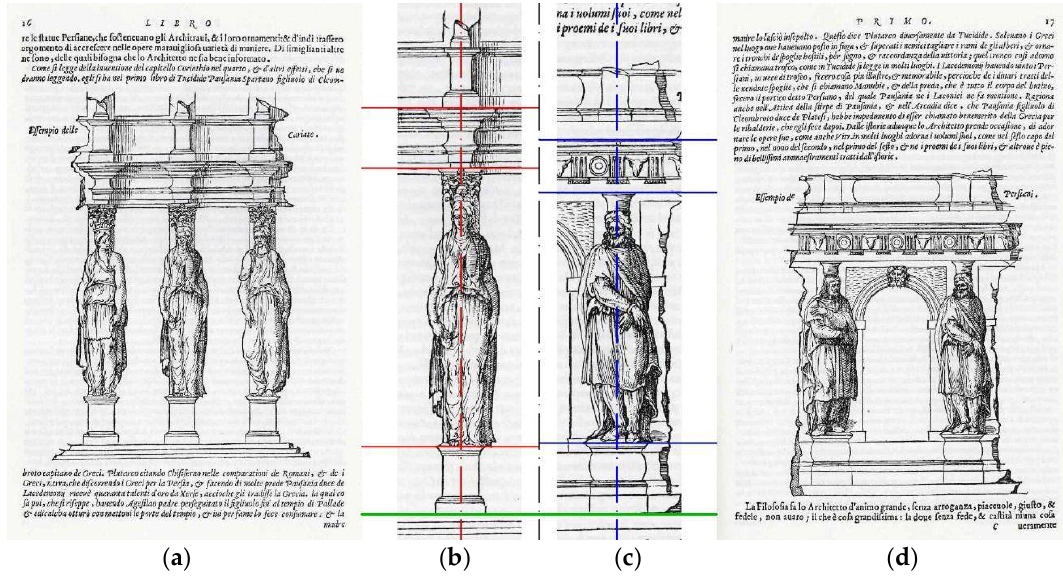
Figure 9. ( a ) Essempio delle Cariate [80] (p. 16) ( d ) Essempio de Persiani [80] (p. 17). Figures can iconize the Vitruvian concept of man or a woman’s body as a measurement/proportioning system; ( b , c ) If we compare the represented subjects (and keeping the proportional scale desired by the author of the publication), it is evident that, although there is no direct correlation between the two modules at the basis of the different systems, figurative compositions tend to strengthen the Vitruvian concept concerning the type of human/architectural order correlation to whom the building is dedicated (although in the specific case, the two proposals do not refer to temples or buildings dedicated to a deity, but to architectures designed to graphically express both the caryatids’ origins myth and the Greek’s victory over the Persians tale). Red and blue lines show the respective patterns of ‘compositional geometries’ of the presented cases, both growing from the green